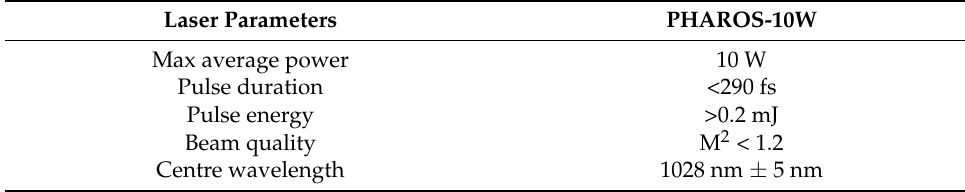
Figure 1. Schematic diagram of the experimental setup. Table 1. Parameters of the femtosecond laser.